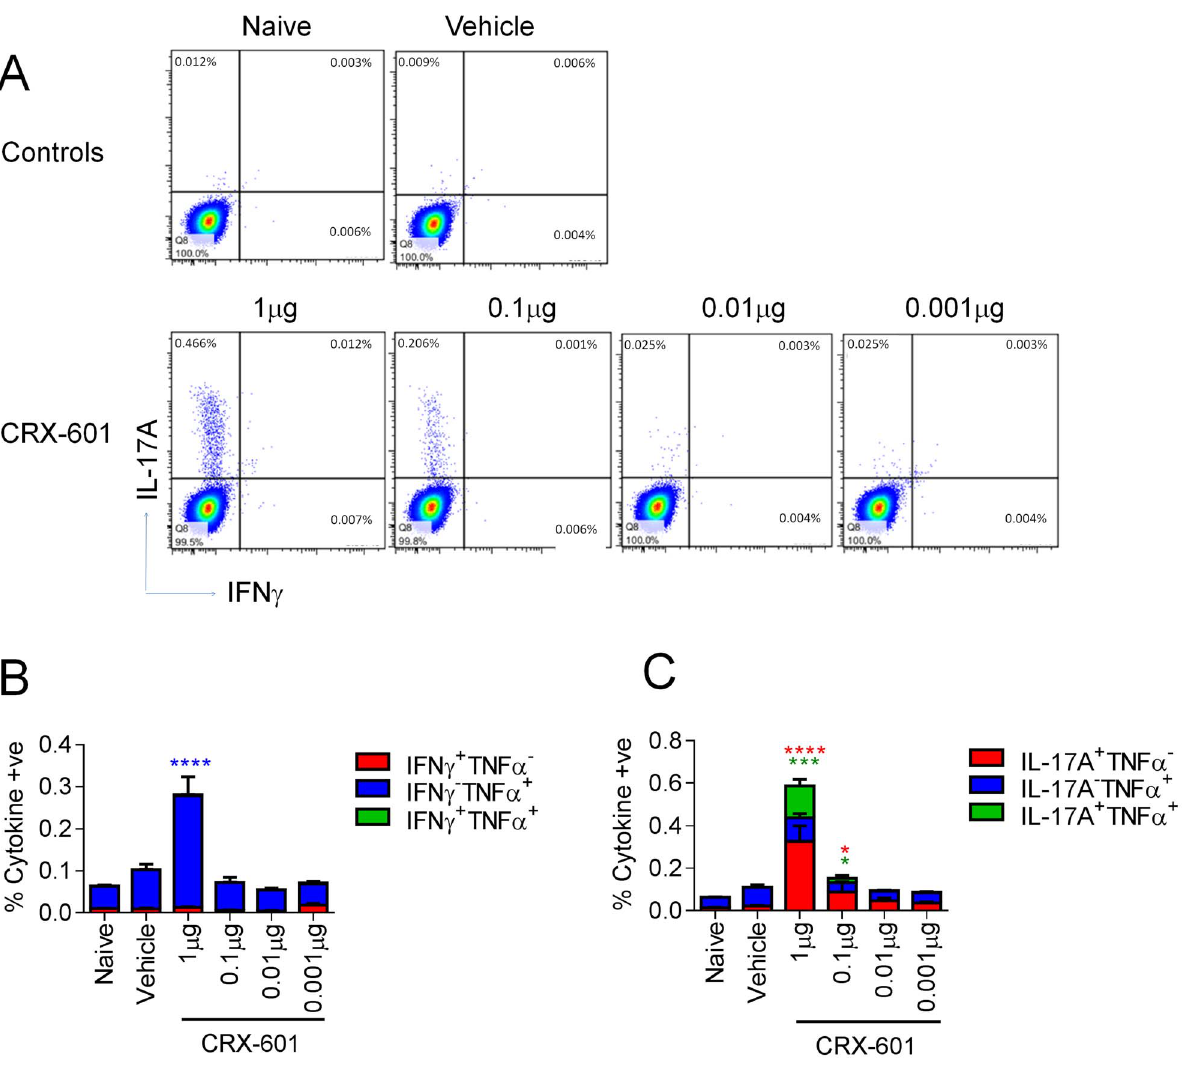
Figure 2. Induction of Th17 cells following intranasal vaccination with liposomal CRX-601 and split flu antigen. Antigen-specific T cell responses in mice vaccinated intranasally with split influenza virus antigen (A/Uruguay/716/2007 (H3N2)) and various concentrations of CRX-601 liposomes were evaluated in the spleen at day 5 post-secondary vaccination. Expression of IL-17A/IFN c (A), IFN c /TNF a (B) and IL-17A/TNF a (C) were examined in CD4 + T cells. Data shown is representative of 3 independent experiments. Data in B and C are means 6 SEM for three replicates analyzed by two-way ANOVA, Bonferroni post test analysis (* p , 0.05, ** p , 0.01, ***p , 0.001, **** p , 0.0001 are significantly different from naive controls).